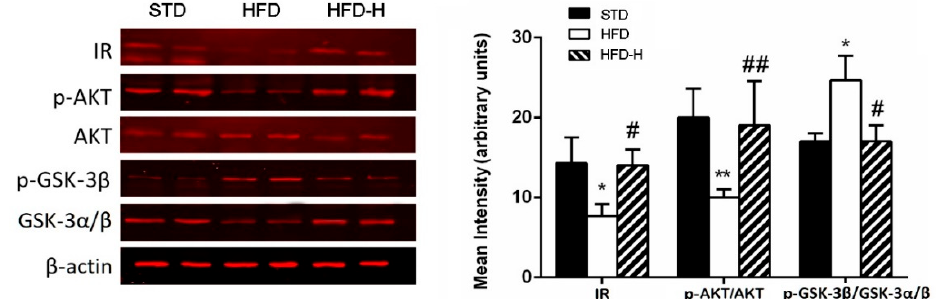
Figure 5. Effects of long-term honey ingestion on expression of insulin signaling protein HFD mice. Honey improved insulin signaling in HFD brain. Western blot of protein extracted from brain lysates of different mouse groups and incubated with anti-insulin receptor (IR), anti-p-AKT, anti-AKT, anti-p-GSK-3 β , anti-GSK-3 α / β and β -actin antibodies. Honey prevented the expression changes in insulin receptor (IR), p-AKT and p-GSK-3 caused by HFD. Data are mean values ± S.E.M. ( n = 8/group). * p < 0.05, ** p < 0.01 vs. STD mice; # p < 0.05, ## p < 0.01 vs. HFD. STD: standard mice; HFD: high fat diet mice; HFD-H: high fat diet supplemented with honey